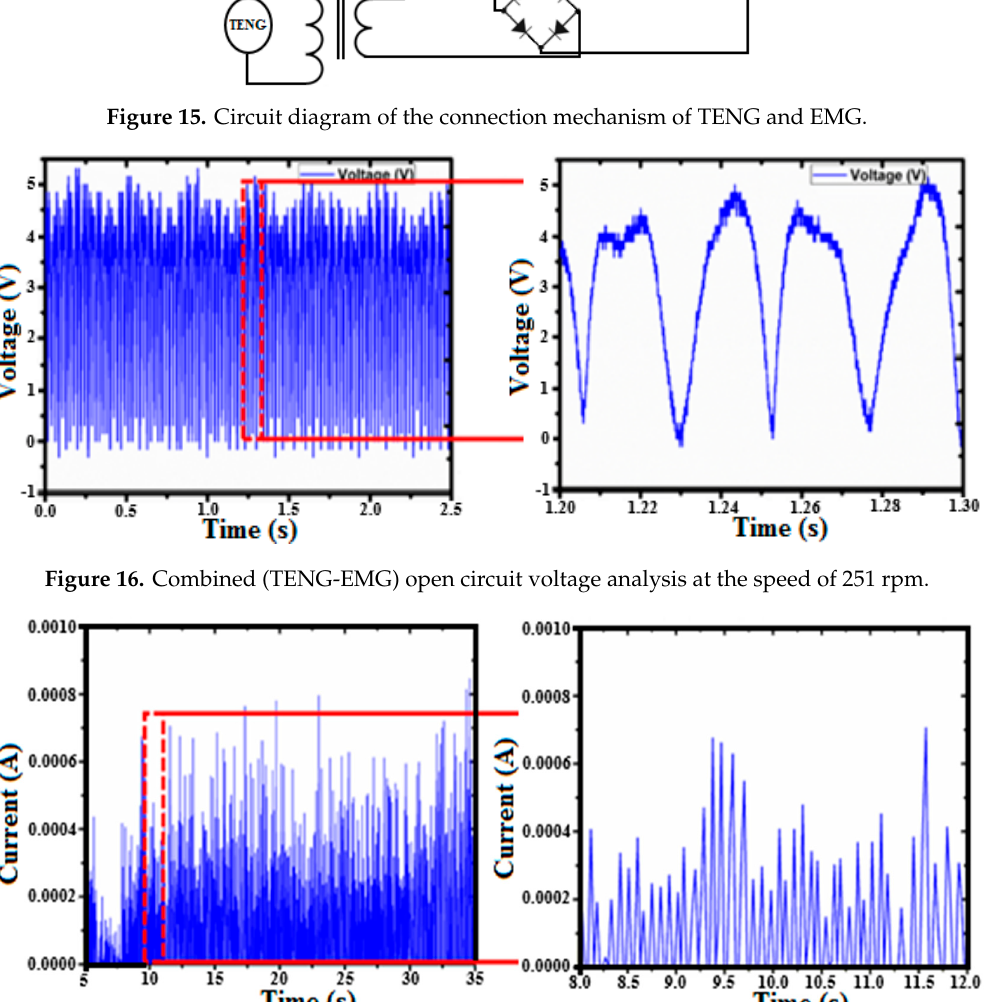
Figure 17. Combined (TENG-EMG) short circuit analysis at a rotational speed of 251 rpm.